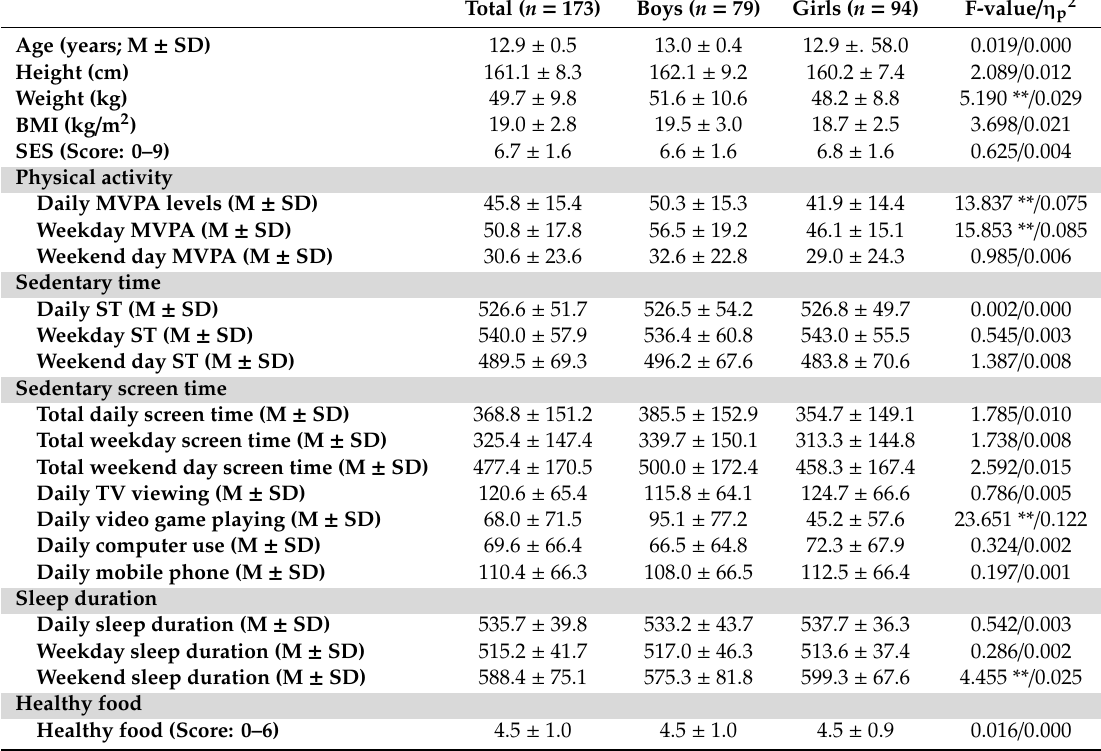
Table 1. Sociodemographic characteristics and prevalence of health-related behaviors by